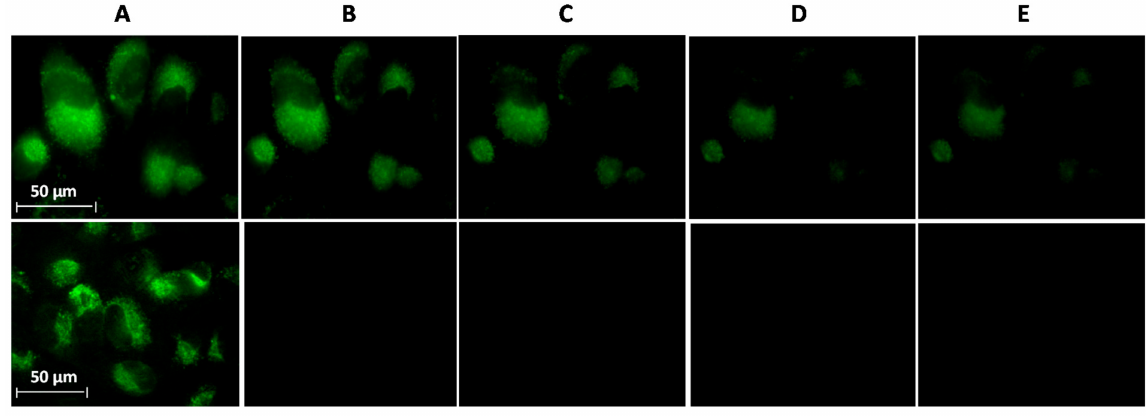
Figure 4. Images collected during photobleaching experiments. HeLa cells incubated (top) during 1h and 30 min with a 210 µ M solution of the 4i probe or (bottom) during 30 min with 50 nM LysoTracker Green DND-26 after exposure to a continuous excitation light selected with a 417 nm (band pass 60 nm filter) collected at different times: ( A ) 0 s, ( B ) 30 s, ( C ) 75 s, ( D ) 180 s, ( E ) 485 s. The emission signal was collected with a 536 nm band pass 54 nm, τ exp : 500 ms, 63 ×